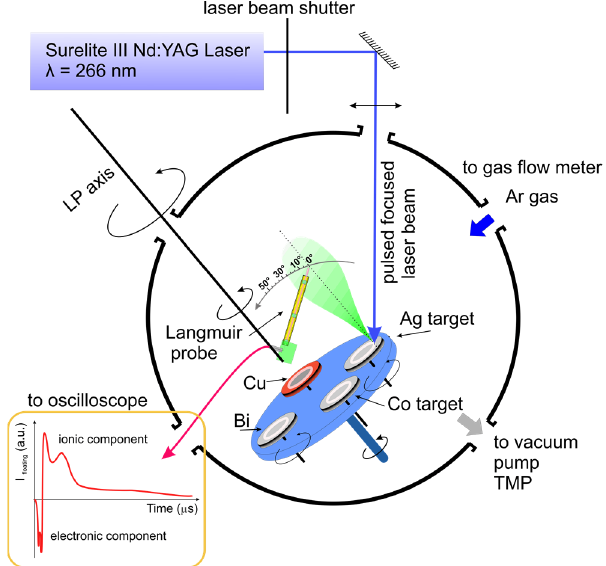
Figure 1. Experimental Set-up.